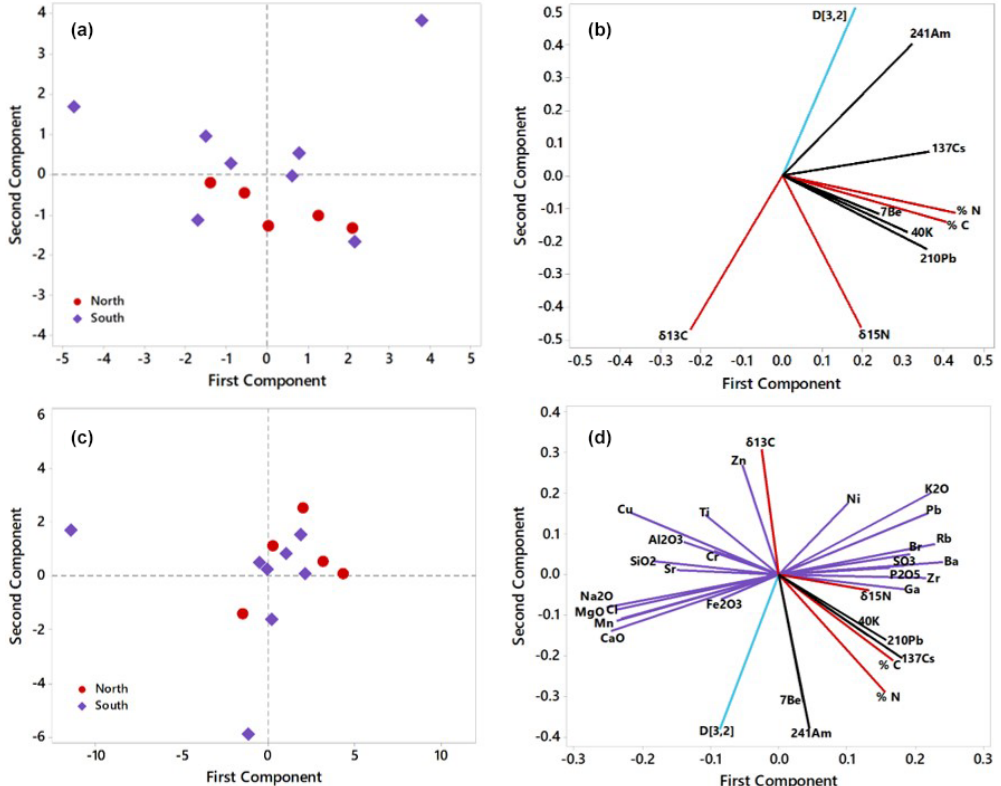
Figure 4. Principal component analysis (PCA) for cryoconite samples G1–G13, excluding (a, c) and including (b, d) major and minor elements from XRF analysis. Data are grouped by position on the glacier terminus (north and south; see Fig. 1) for the PCA scores (a, c) . The PCA loading plots depict eigenvector values for FRNs (black), C and N analysis (red), and particle size analysis (blue) in panel (b) , with the inclusion of major and minor elements (purple) in panel (d) . Principal components 1 and 2 are depicted here; see table A2 for eigenvectors for principal components 1 to